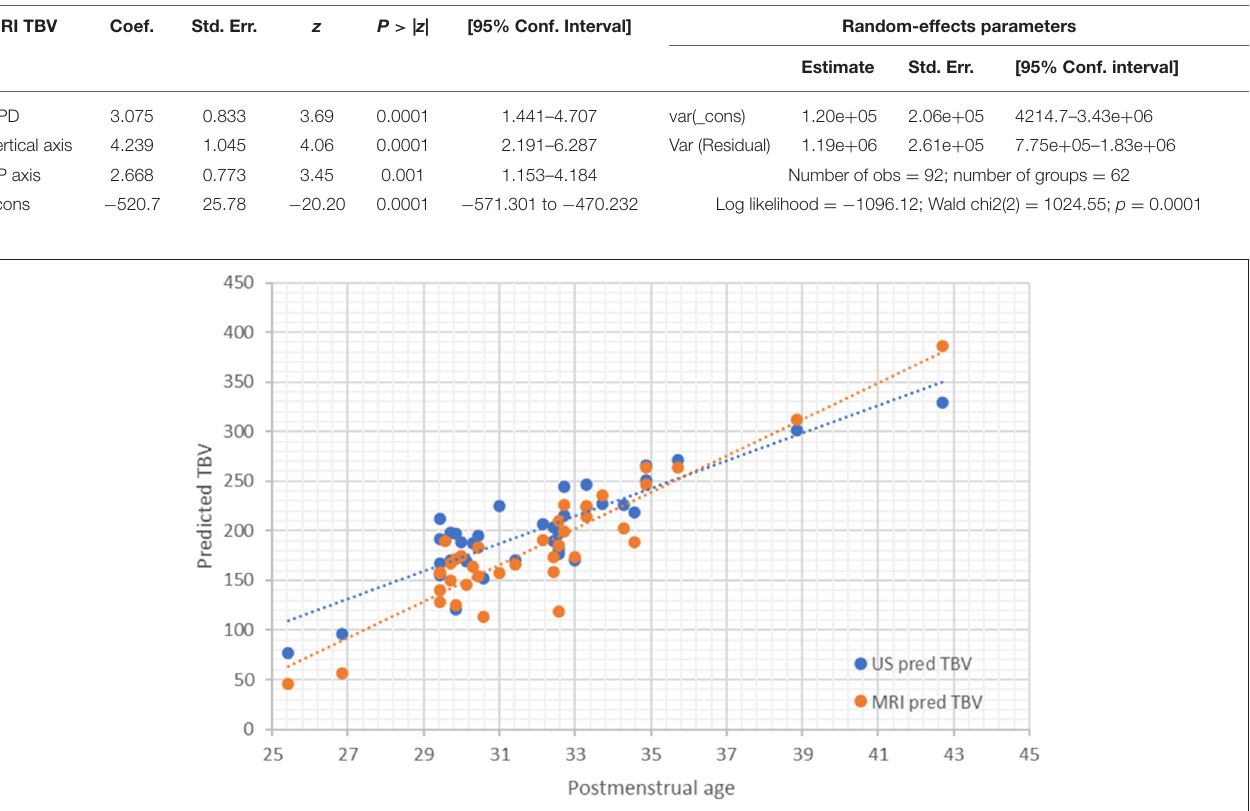
MRI-TBV based on the axes would follow this